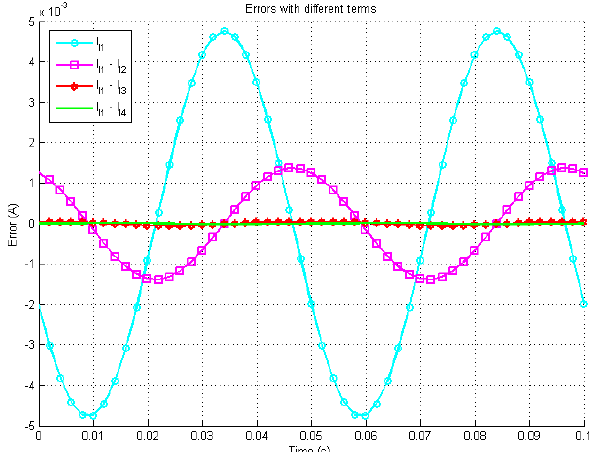
Figure 3. Simulation output and iterative solutions.